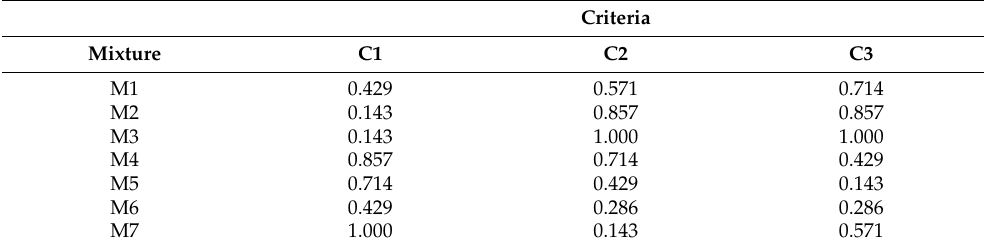
Table A1. Normalized decision matrix for the MEREC method.